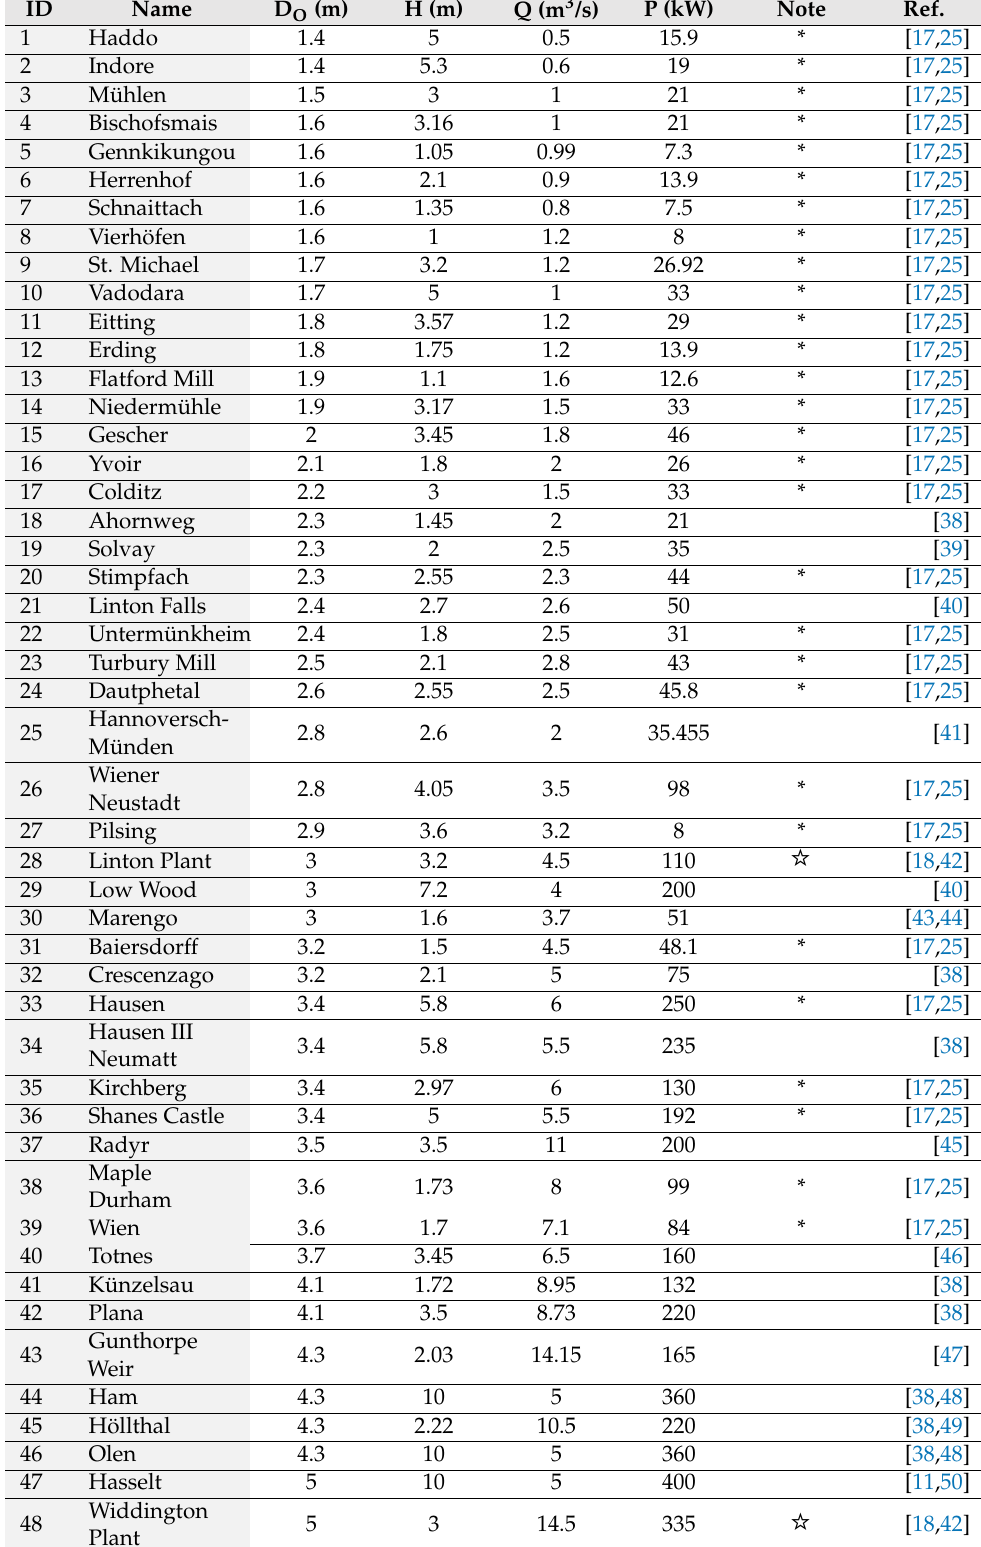
Table 2. Details of Archimedes screw hydropower plants used for model